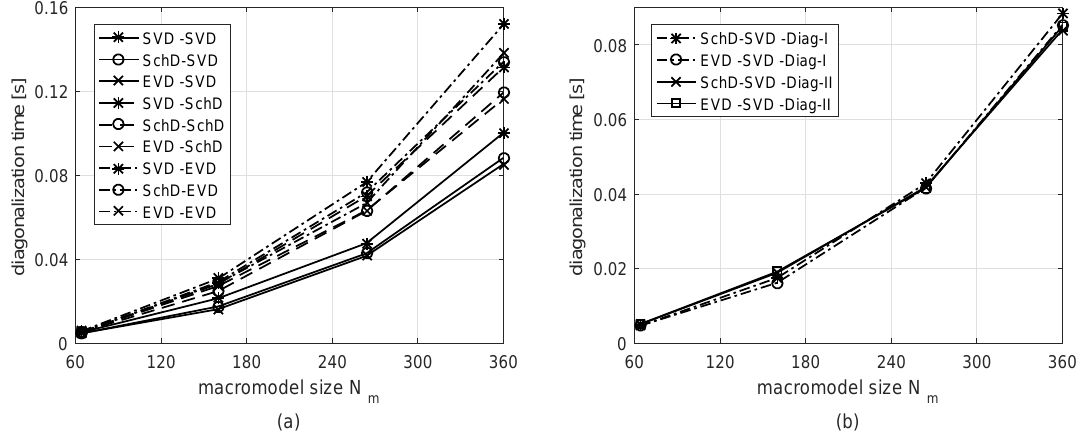
Figure 8. Diagonalization time t D 1 for one macromodel of the size N m = 2 qp 0 for the following configurations: algorithm Diag-I with all possible combinations of orthogonal decompositions ( a ); and both algorithms Diag-I and Diag-II with the best performing orthogonal decompositions ( b